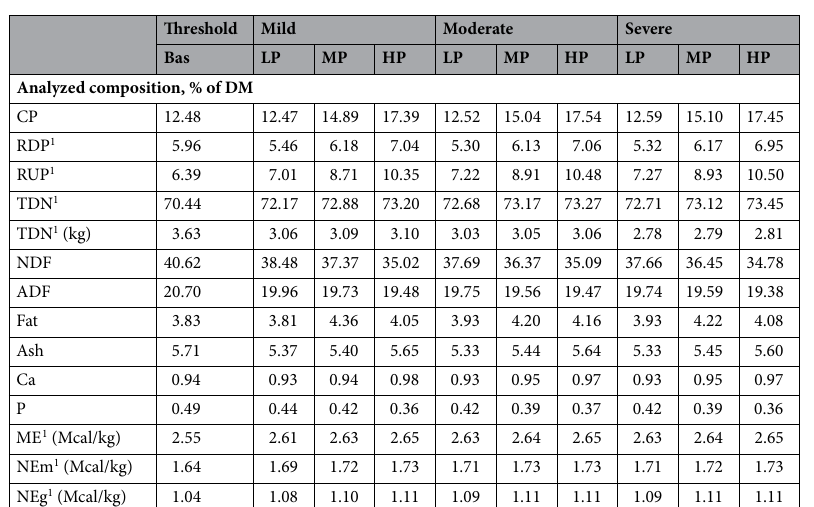
Table 2. The chemical composition of experimental diets provided to the Korean native beef calves. 1 Values were estimated using NRC (2016). THI = Temperature humidity index, THI = (1.8 × Tdb + 32) – [(0.55 – 0.0055 × RH) × (1.8 × Tdb − 26.8). Threshold = THI 70 to 73, Mild = THI 74 to 76, Moderate = THI 81 to 83, Severe = THI 89 to 91. LP = Low protein (12.5%), MP = Medium protein (15%), HP = High protein